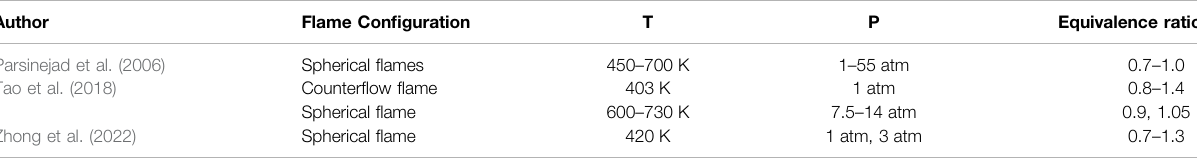
TABLE 1 | Laminar fl ame speed studies of JP-10 in literature.